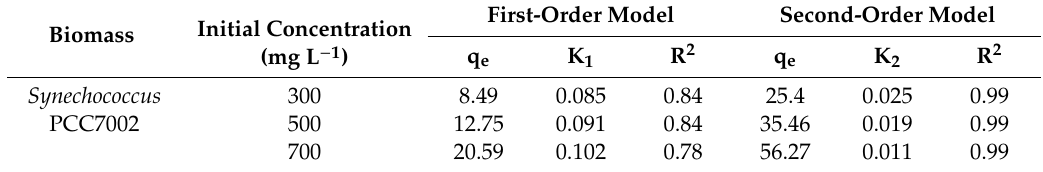
Figure 3. Kinetics of Cs(I) adsorption on Synechococcus PCC7002 in aqueous solution fitted using the pseudo-first-order model ( a ) and pseudo-second-order model ( b ). Table 1. Kinetic parameters for the biosorption of Cs(I) onto Synechococcus